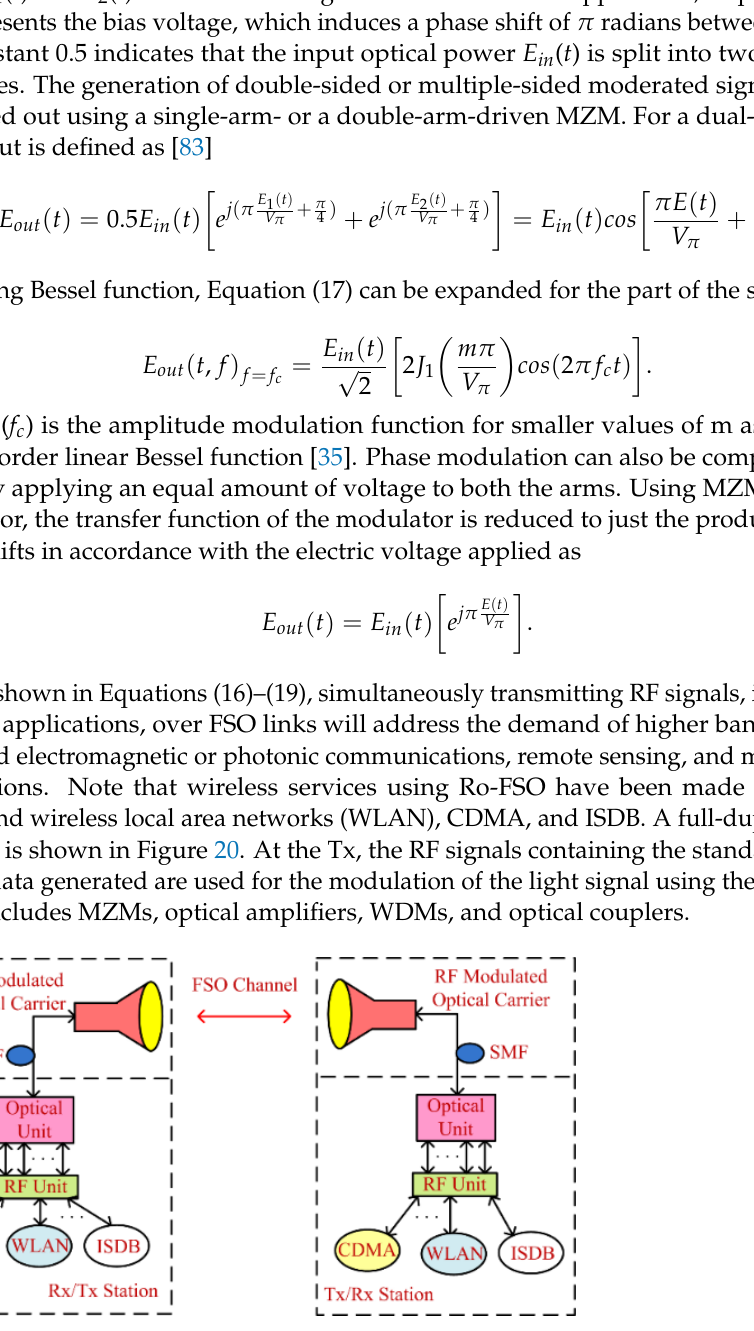
Figure 20. Top level schematic of a full-duplex Ro-FSO system.